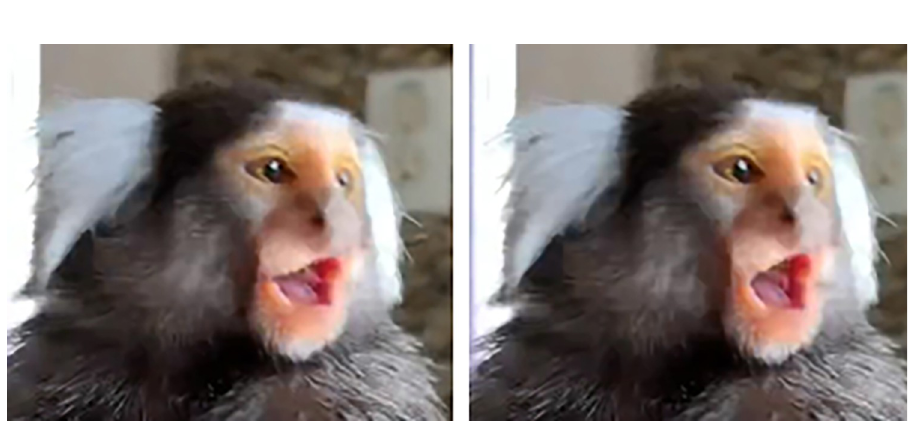
Fig 16. AU118—Lip Pucker. Left: AU25 and AU27 are present; Right: AU118 is added to AU25+AU27.